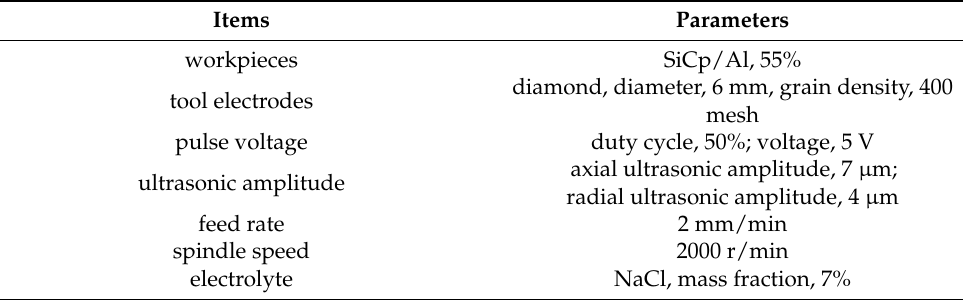
Table 2. Machining parameters with and without detection